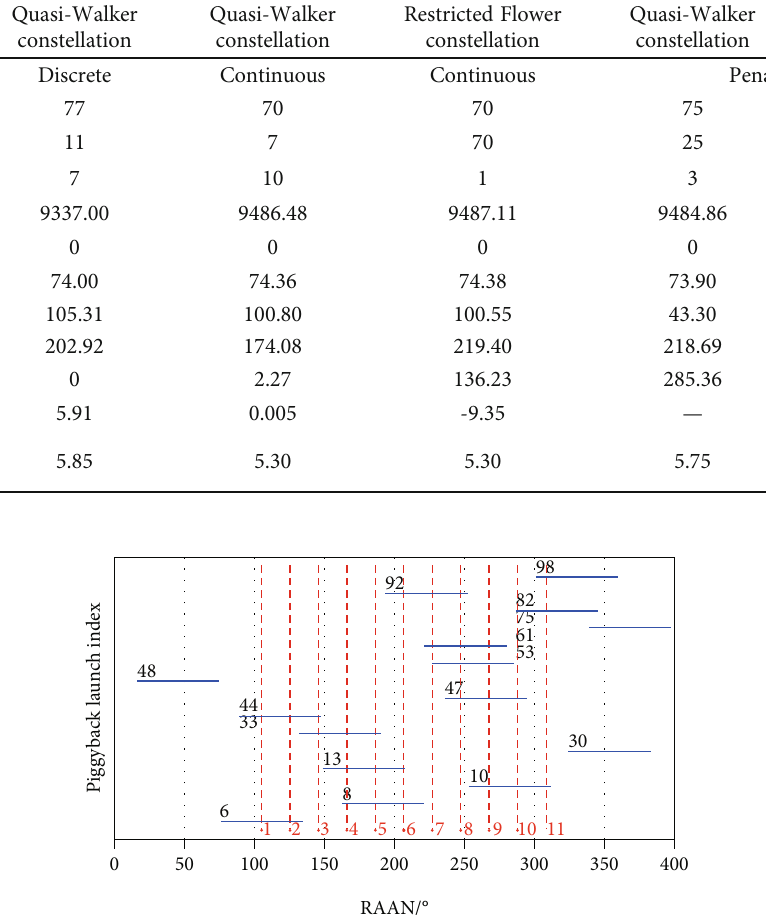
Figure 15: Correspondence of piggyback launches and target orbital